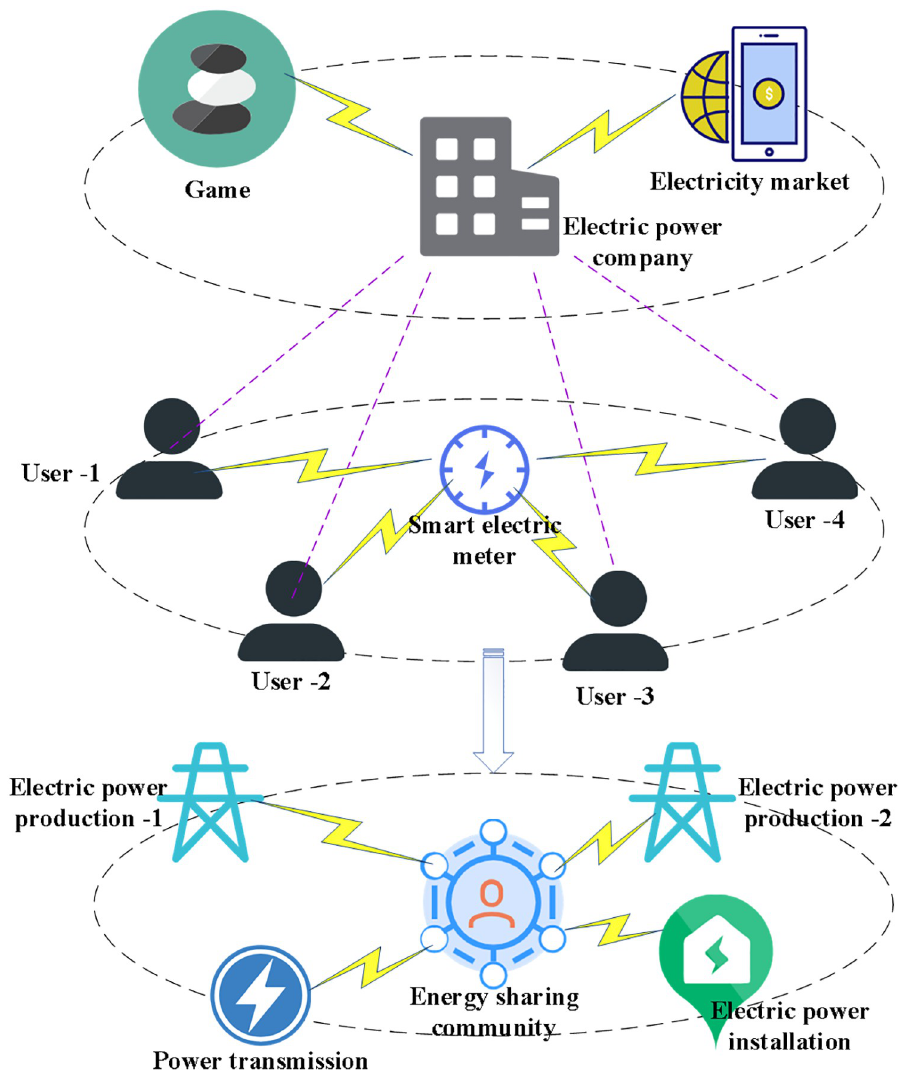
Fig 4. Modeling of virtual power